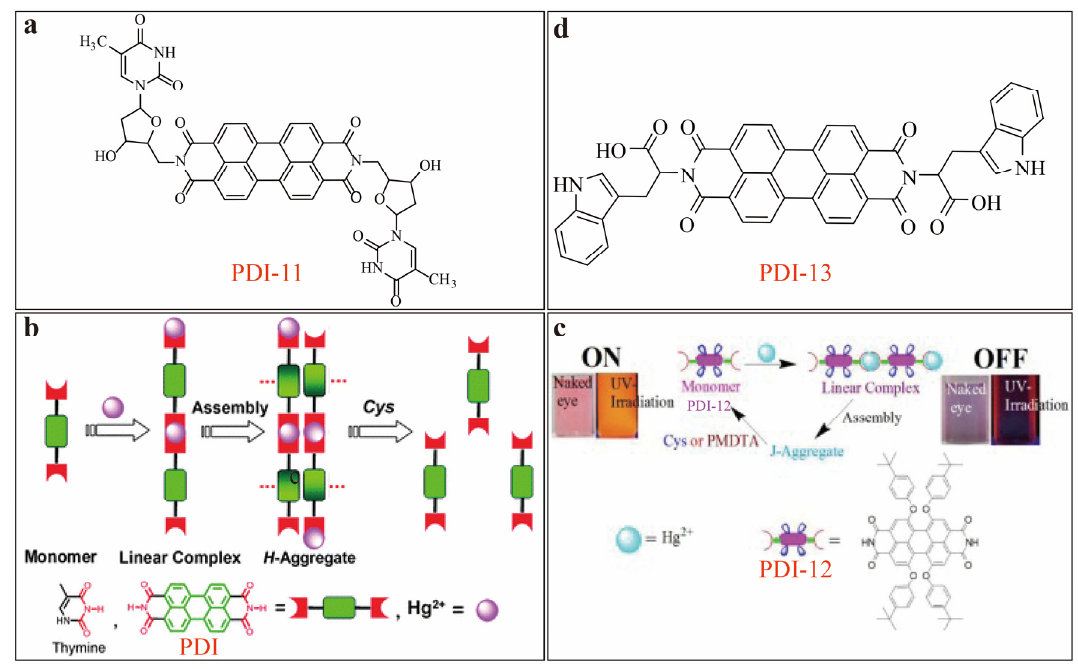
Figure 5. ( a ) Molecular structure of PDI-11. ( b ) Scheme of Hg 2+ –coordination induced aggregation of PDIs and the dissociation caused by competitive complexation of cysteine. Reproduced with permission from [18], copyright 2010 Royal Society of Chemistry. ( c ) Scheme of Hg 2+ -coordination induced J -aggregation of PDI-12 and cysteine-induced dissociation. Reproduced with permission from [19], copyright 2014 Elsevier B.V. ( d ) Molecular structure of PDI-13.